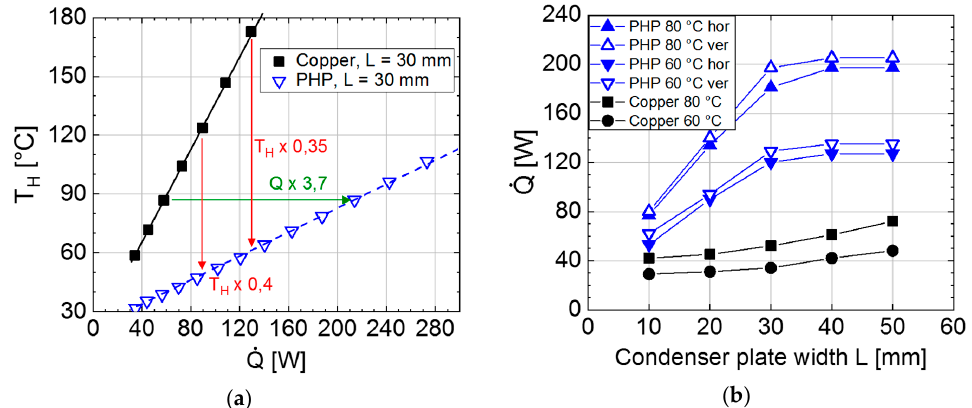
Figure 9. ( a ) Comparison of heater temperature 𝑇 (cid:3009) vs. heating power 𝑄´ between PHP (vertical orientation) and reference copper plate for fixed condenser plate width of 30 mm and a heater width of 25 mm. Lines are given as eye guides; ( b ) plot of 𝑄 ´ for defined 𝑇 (cid:3009) of 60 and 80 °C vs. 𝐿 for PHP (blue triangles) and reference copper plate (black squares and circles). Hor = horizontal orientation. Ver = vertical orientation. For the copper plate, the values for horizontal and vertical orientation are identical and thus, only one value is given for each.